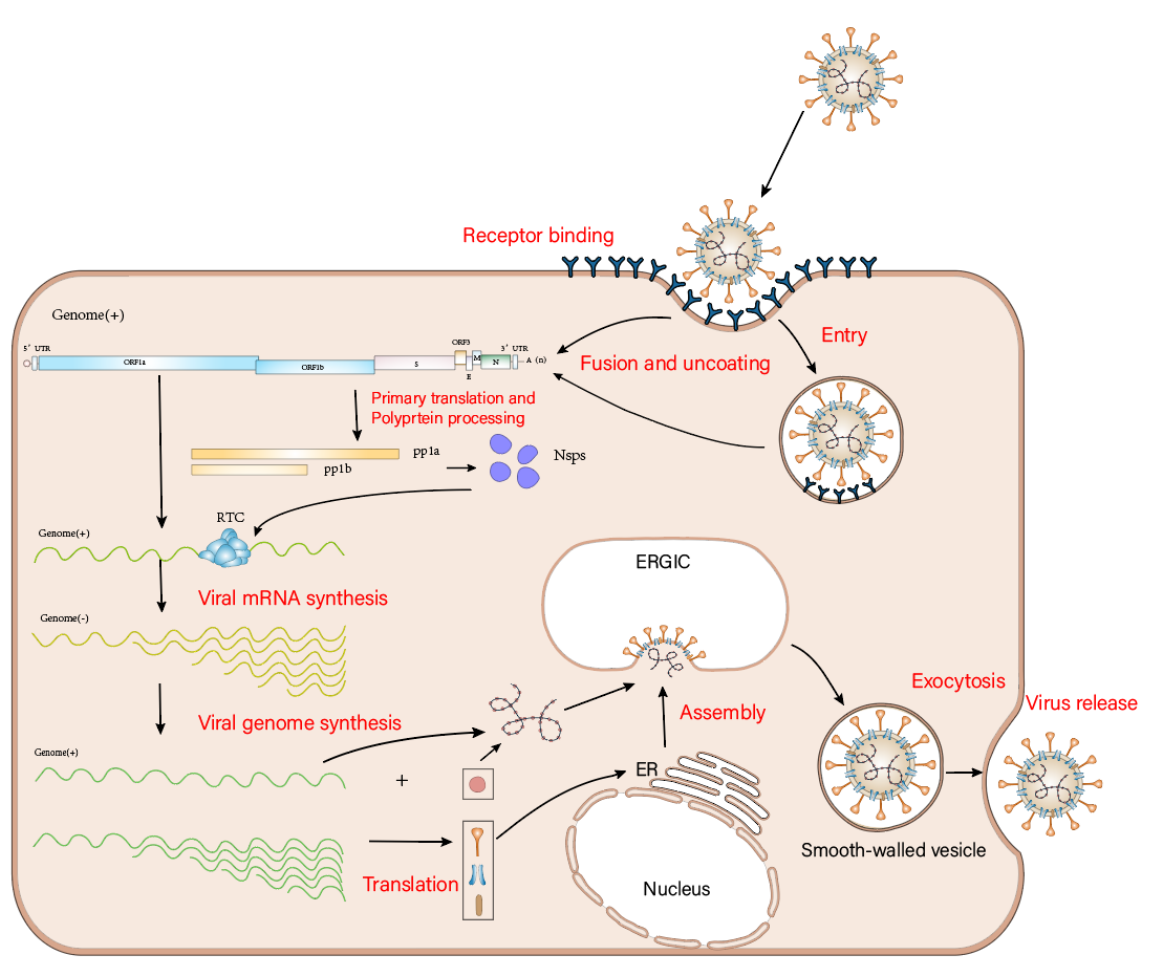
Figure 3. Overview of the PEDV life cycle.